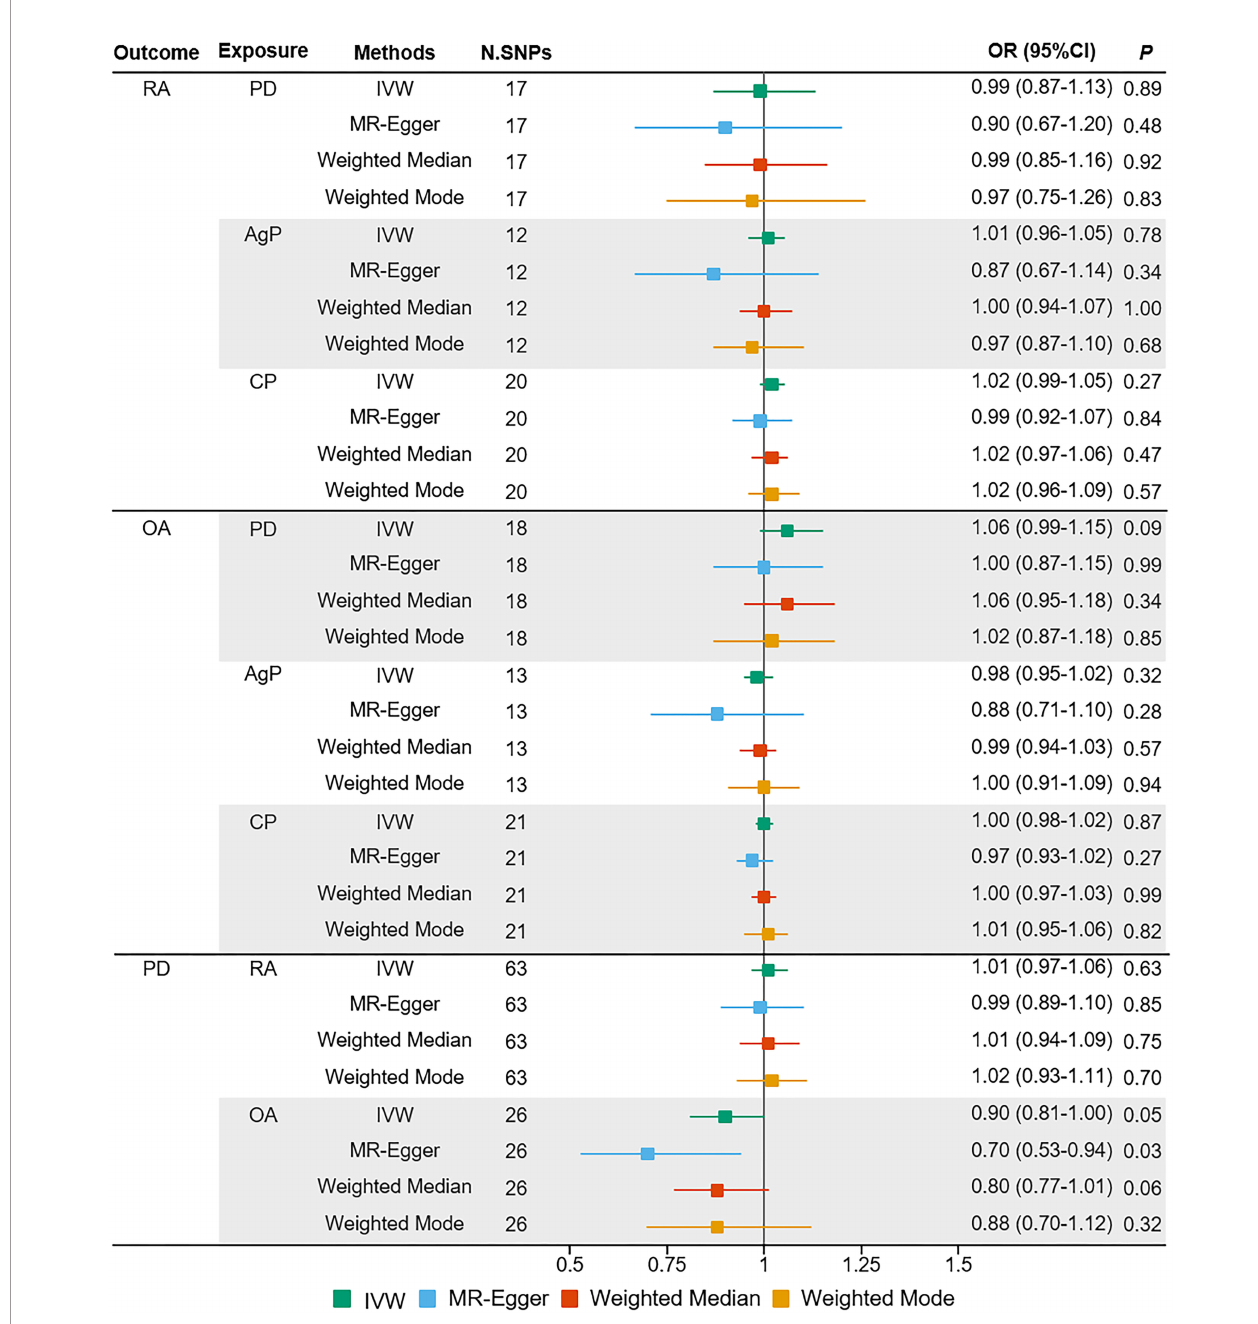
FIGURE 1 | Estimated causal effects between PD and arthritis using different MR methods. AgP, aggressive periodontitis; CI, con fi dence interval; CP, chronic periodontitis; IVW, inverse variance weighted; N.SNPs, number of SNPs used in MR; OR, odds ratio; PD, periodontitis; RA, rheumatoid arthritis; OA,